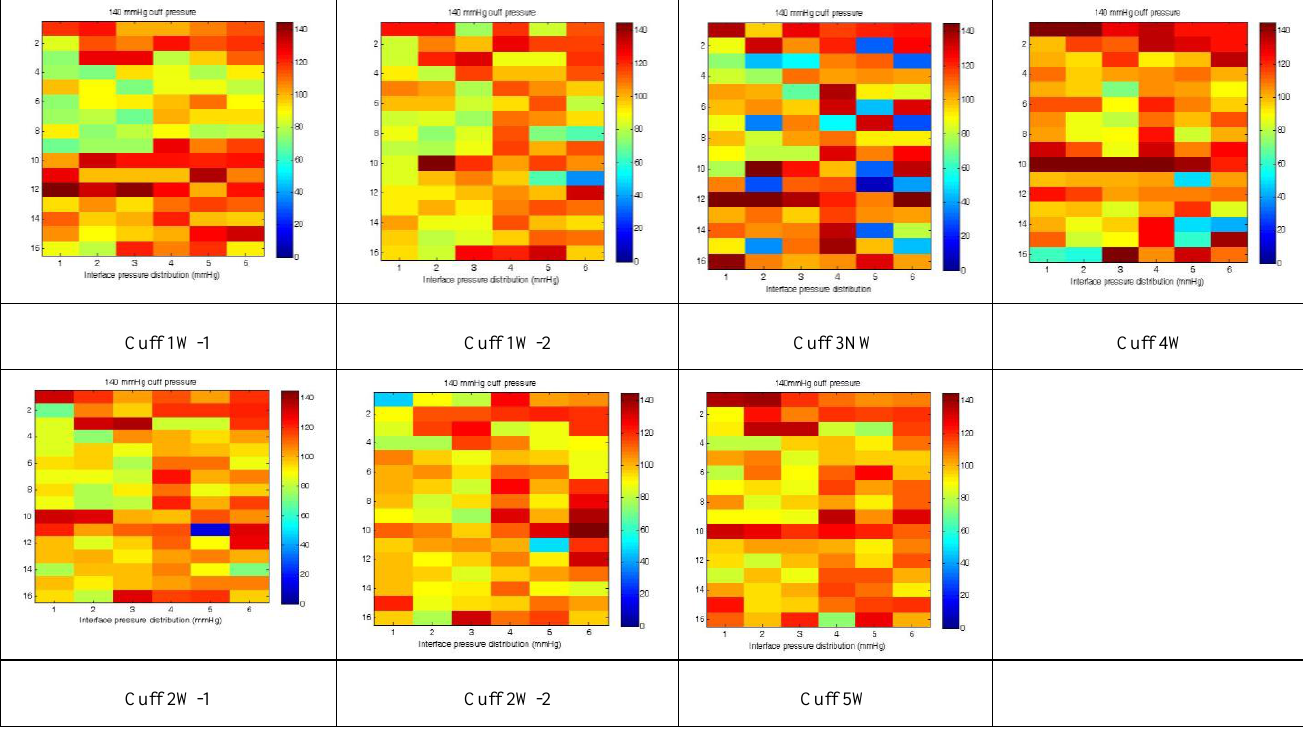
Fig. 4(b) Pressure distribution at cuff – metal cylinder interface at 140 mmHg inside cuff